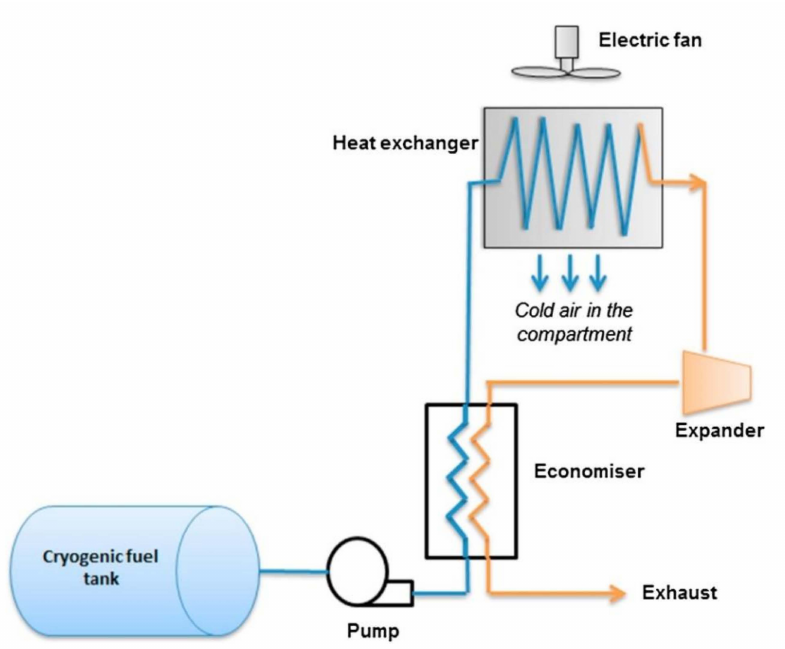
Figure 10. Schematic diagram of indirect cryogenic transport refrigeration system. Reprinted from ref.